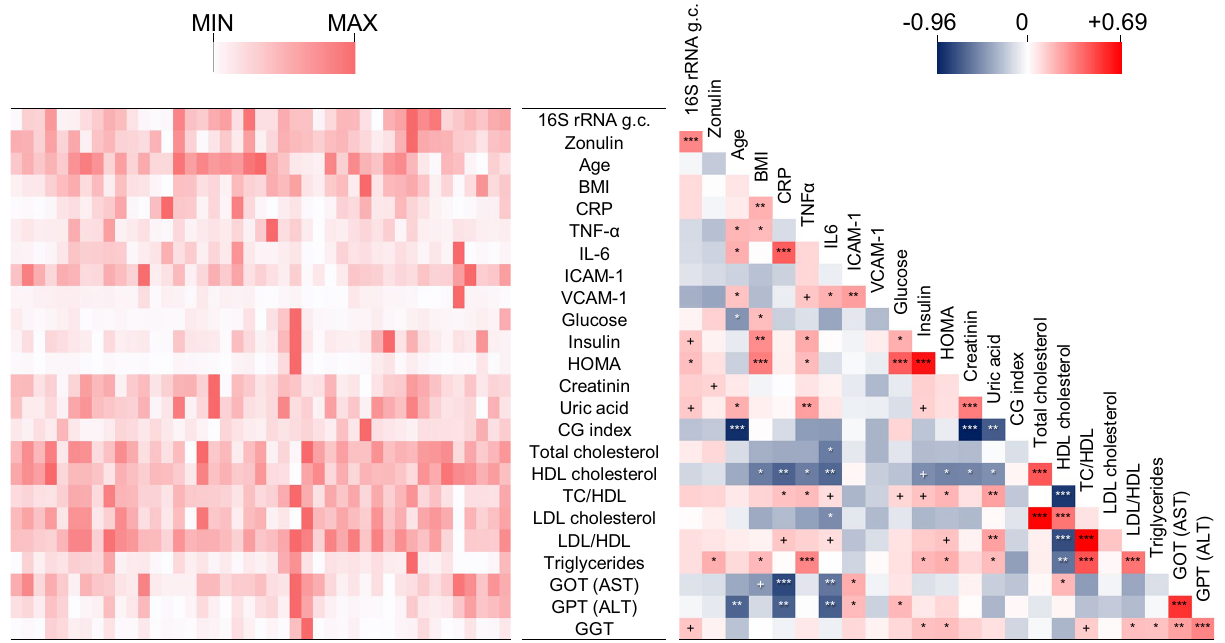
Figure 2. Correlations between bacterial DNAemia, age, BMI, and metabolic and functional markers determined in blood of the older subjects under study (n = 43). The heatmaps on the left (white-red color gradient) refers to the distribution among older subject of the item reported in the central column. The heatmap on the right (blue-white-red color gradient) represents the Spearman’s correlation coefficient, ρ. Asterisks indicate the Kendall rank correlation P value: *** P < 0.001; ** P < 0.01; * P < 0.05; + , 0.05 < P ≤